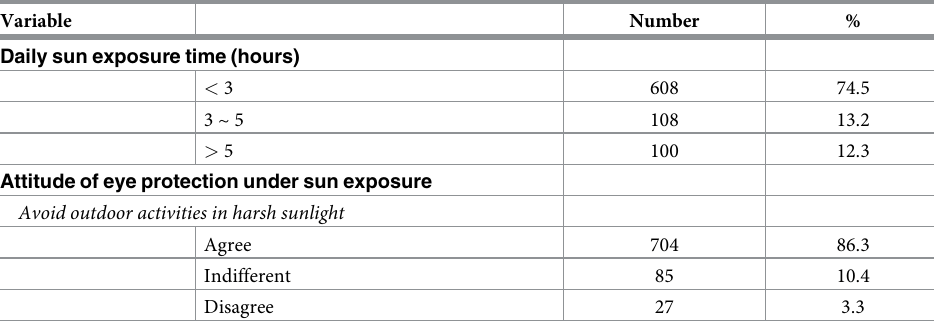
Table 2. Attitudes of eye protection under sun exposure and pattern of daily practices.